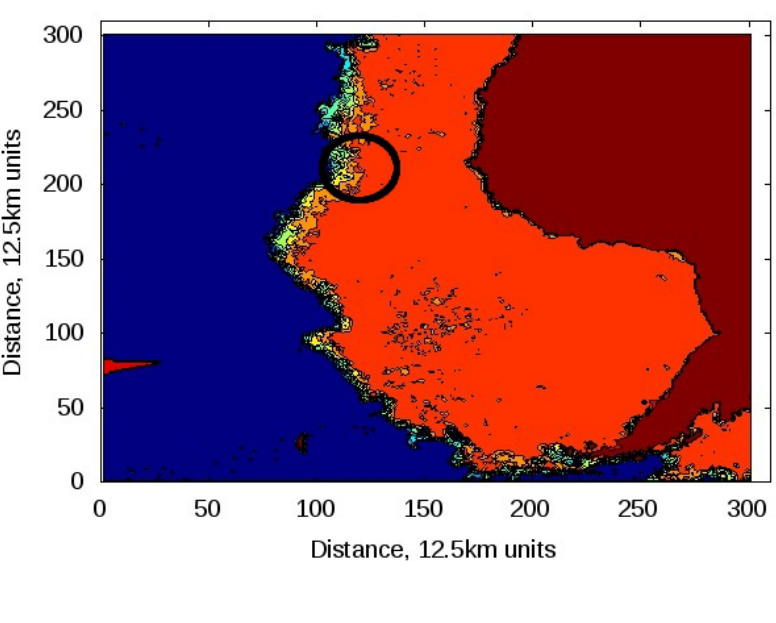
Figure 3. Data from the AMSR-E instrument on the Aqua satellite for June 23, 2005. Including the total ice concentration over the collection region. The greater collection region is circled in black and the ice concentration over the reflection path is shown in Figure 4. Dark blue represents ocean, increasing ice concentration changes from blue to dark orange and land is shown in